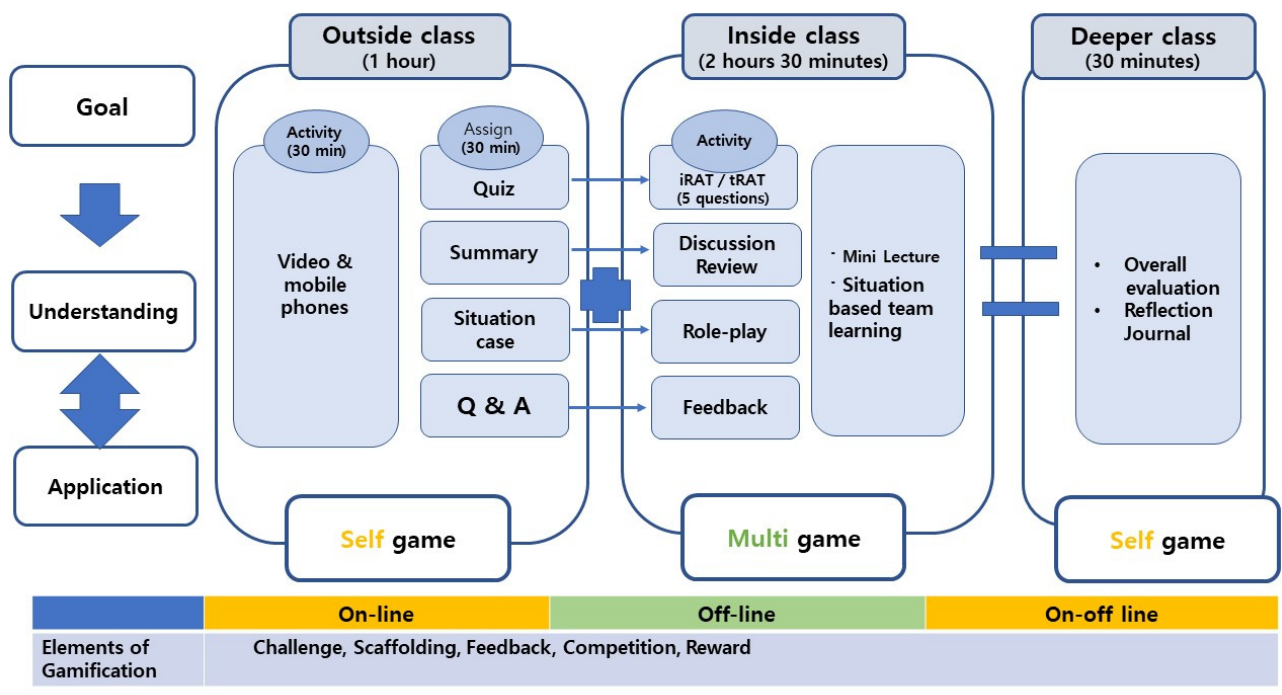
Figure 1. Situation-based flipped learning and gamification as combined methodologies in psychiatric nursing education. Abbreviations: FL: Flipped Learning; iRAT: Individual Readiness Assurance Test; tRAT: Team Readiness Assurance Test.